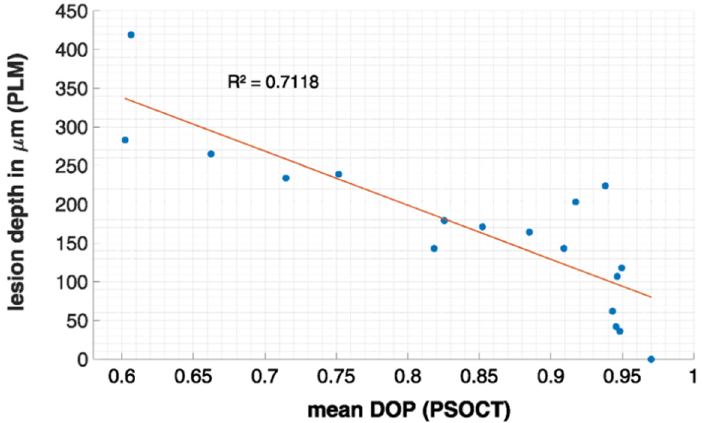
Figure 2. Correlation between the calculated mean DOP by PS-OCT and determined lesion depths by PLM. This figure was adapted from [77]. Table 4. Results of quantifying enamel caries with degree of polarization.